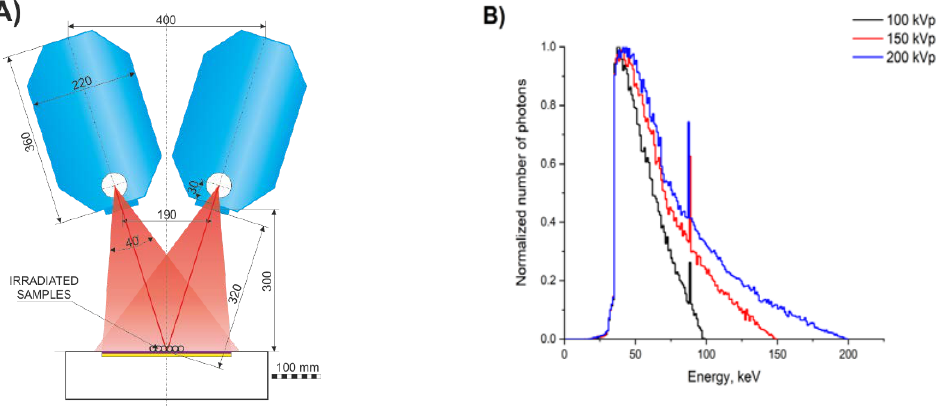
Figure 2. ( A ) Scheme of irradiation. ( B ) Spectra of RUST-M1 at various X-ray tubes voltages calculated Figure 2 using Monte-Carlo simulation: 100 kVp (black), 150 kVp (red), and 200 kVp (blue). DNA samples were centrifuged (11,000 rpm, 15 min) immediately after irradiation to remove